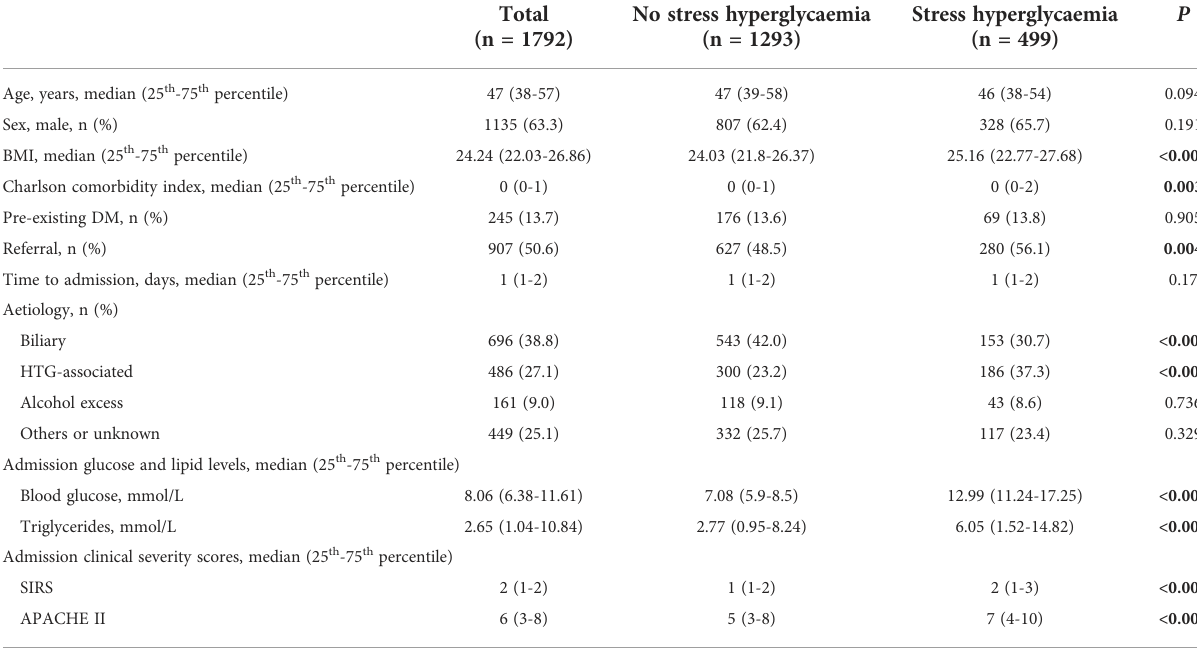
TABLE 1 Baseline characteristics of patients with or without stress hyperglycaemia on